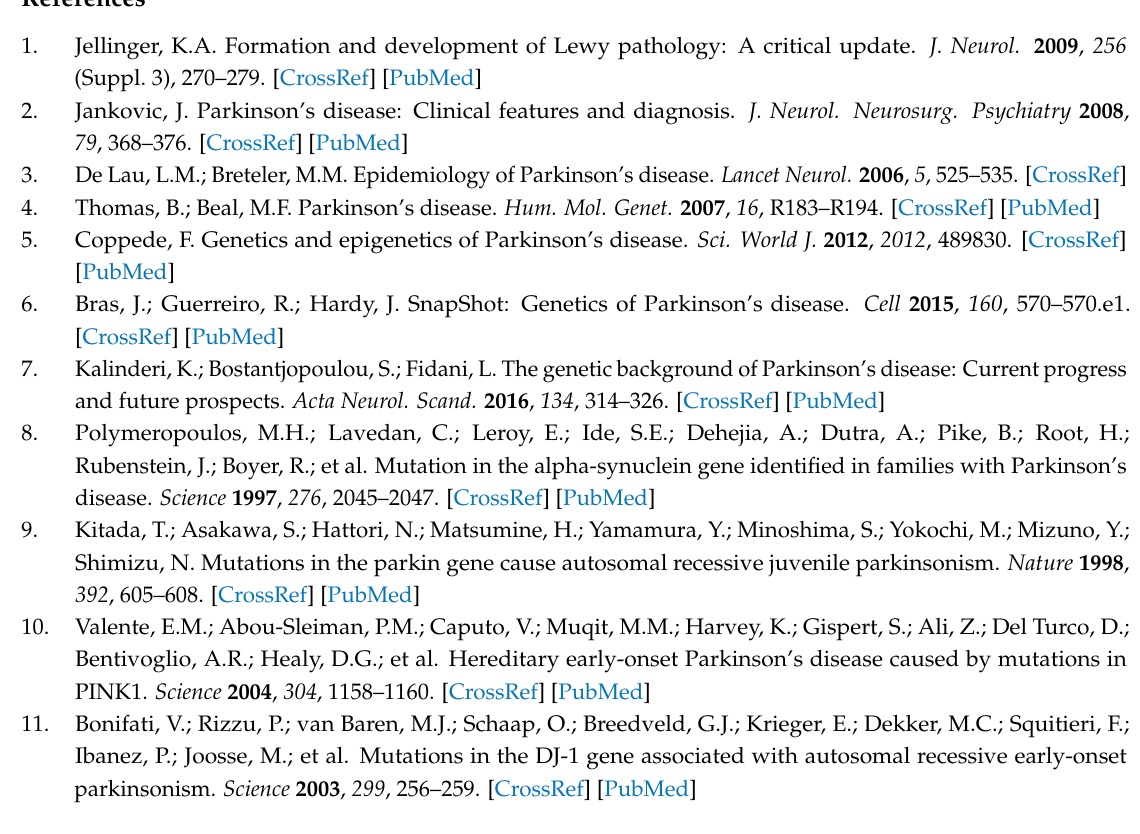
Figure S1: Schematic representation of the regions of interest in SNCA (A, B), LRRK2 (C, D), PRKN (E, F), PINK1 (G, H) and DJ-1 (I, J), Figure S2: Results for all three assays in SNCA in the parietal and occipital cortices and Substantia nigra from PD patients and controls, Figure S3: Results for the two assays in LRRK2 in the parietal and occipital cortices and Substantia nigra from PD patients and controls, Figure S4: Results for the two assays in PRKN in the parietal and occipital cortices and Substantia nigra from PD patients and controls, Figure S5: Results for the assay in PINK1 in the parietal and occipital cortices and Substantia nigra from PD patients and controls, Figure S6: Results for the two assays in DJ-1 in the parietal and occipital cortices and Substantia nigra from PD patients and controls, Table S1. Description of the parameters used for the epigenetic analysis of DNA methylation levels by pyrosequencing, Table S2. Characteristics of the CpG islands predicted by the software employed in this